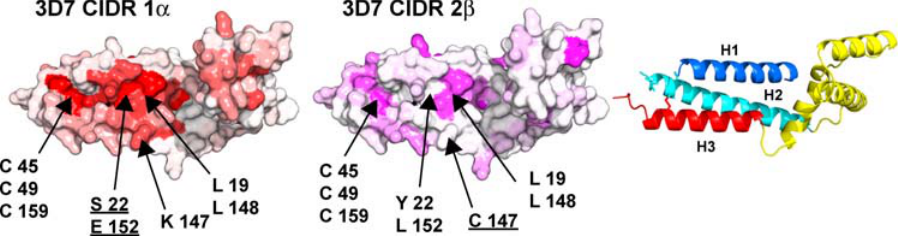
Figure 4. Comparison of CIDR1 a and CIDR2 b conserved surfaces. Sequence conservation (Figures S1 and S3) has been mapped as in Figure 3. MC179 has been rotated about 90 u from the orientation in Figure 3 to show the region between the H1 and H3 helices. At left, a bright red patch means that a high percentage of 3D7 CIDR1 a domains contain the same residue at the particular position as does MC179. In the middle, a bright violet patch means that a high percentage of 3D7 CIDR2 b domains contain the same residue at the particular position as does MC179. Appearing at the surface of both types of domain are Cys 45, Cys 49, and Cys 159 that form part of the conserved disulfide bond network and Leu 19 and Leu 148 that make a conserved interaction between H1 and H3. The unusual nearly buried Ser 22-Glu 152 pair is unique to CIDR1 a domains. At position 147, a conserved lysine is found in CIDR1 a domains, but is a cysteine in most CIDR2 b domains. At right is a reference diagram for the orientation of MC179 in this